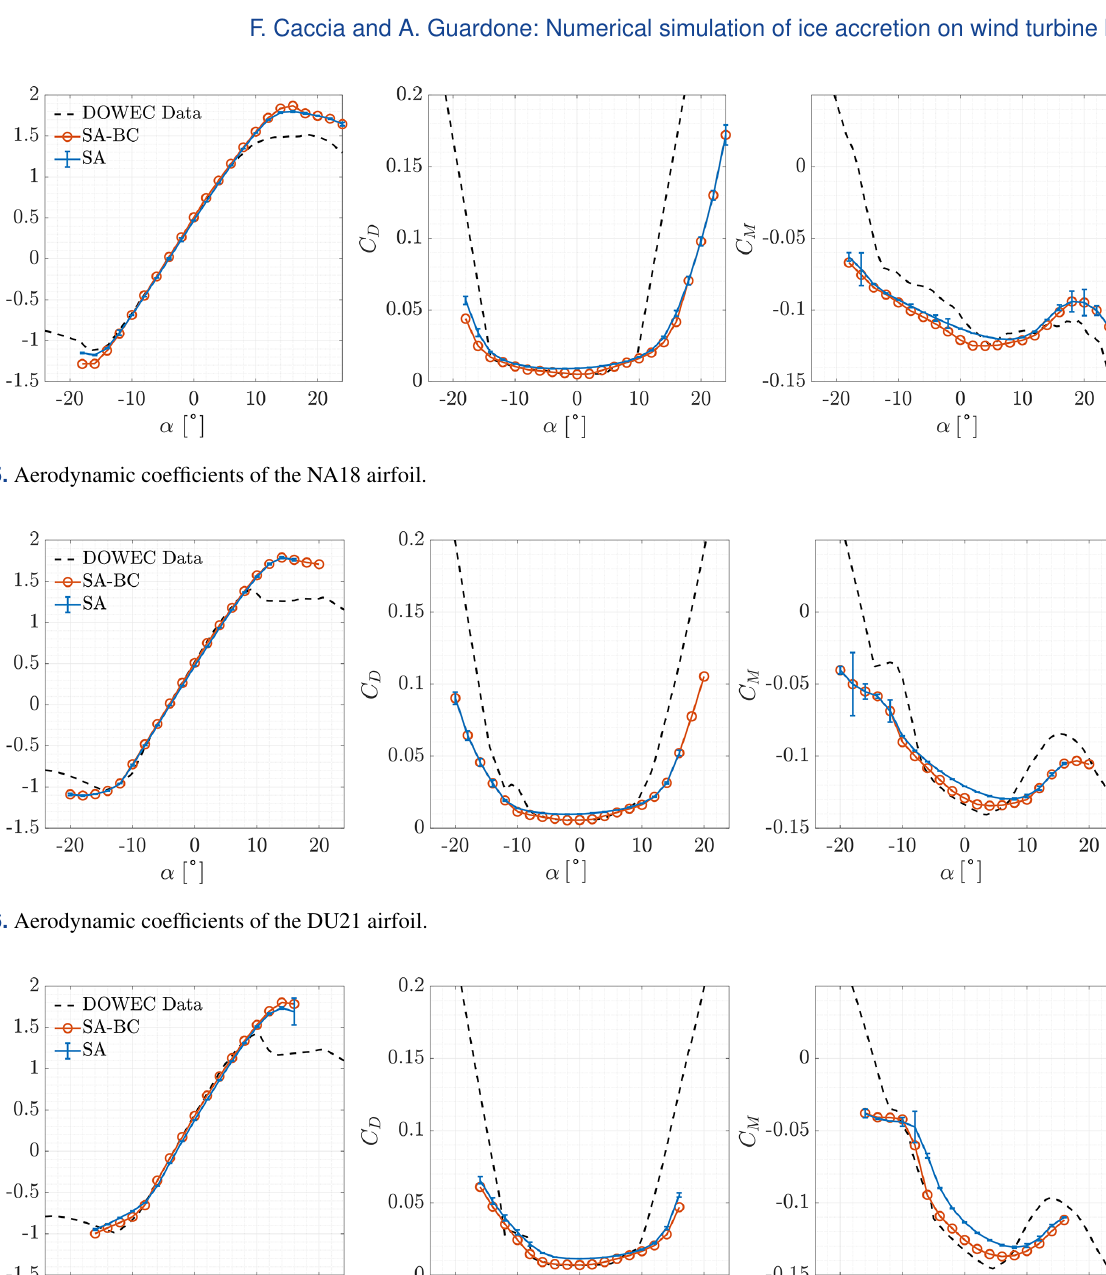
. In the top row, results are for sults obtained with the local k + s k s /c = 0 . 5 × 10 − 3 on the suction side of the airfoil. In the